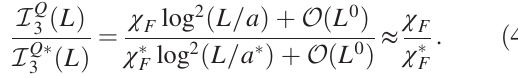
ranging from − 4 to þ 4 . Left: equienergy contours for the nine sets F g is defined by Eq. (4.15), corresponding to two electronlike Fermi pockets; F